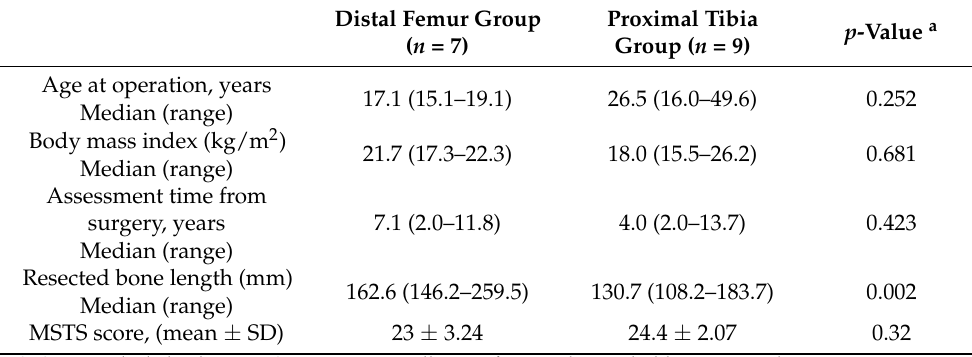
Table 3. Comparison between distal femur group and proximal tibia group.